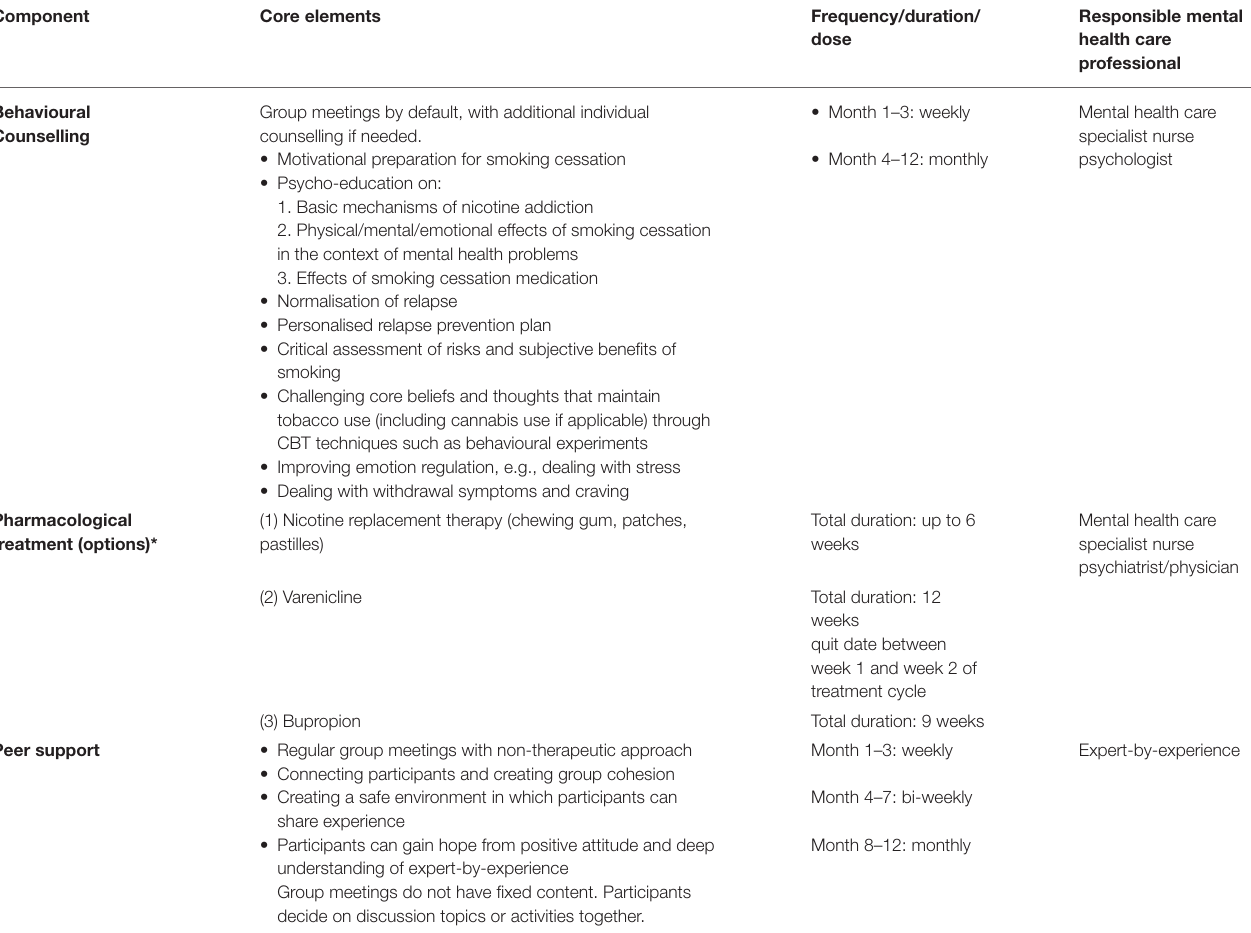
TABLE 1 | Final smoking cessation intervention concept.